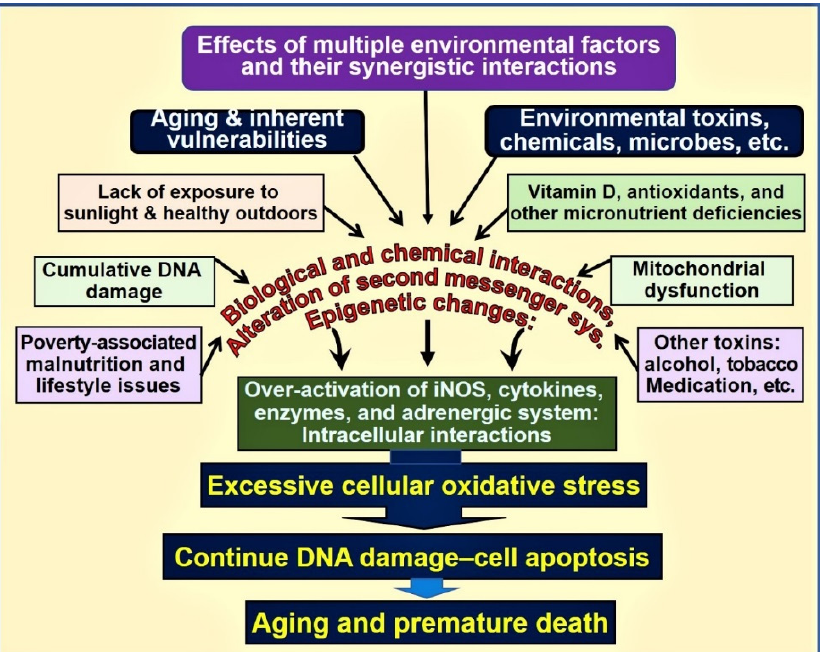
Figure 1. Environmental, microbial, biological and chemical interactions that modify the DNA and mitochondrial functions and epigenetics, which modifies the aging process. Vitamin D deficiency is one of the factors that enhances this oxidative-stress cycle and accelerating premature cell death [abbreviations used: DNA = deoxyribonucleic acid; iNOS = inducible nitric oxide enzyme].